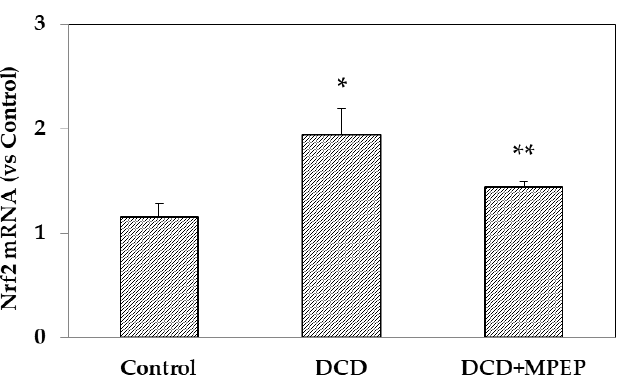
Figure 5. MPEP treatment decreases Nrf2 mRNA in DCD livers during cold storage. Nrf2 was determined in livers stored for 22 h in UW solution. Control animals underwent cold storage; in the DCD group, the livers, after 30 min warm ischemia, were submitted to cold storage. In the DCD-MPEP group, the drug (10 mg/Kg) was administered 30 min before the portal clamping and added to the UW solution (3 µ M). The results are reported as the mean ± SE. * p < 0.05 versus Control;